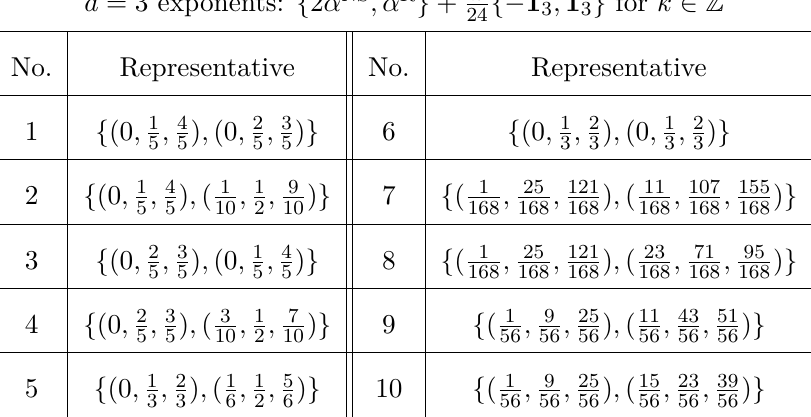
Table 9 . All possible exponents mod 1 for rank 3 non-degenerate